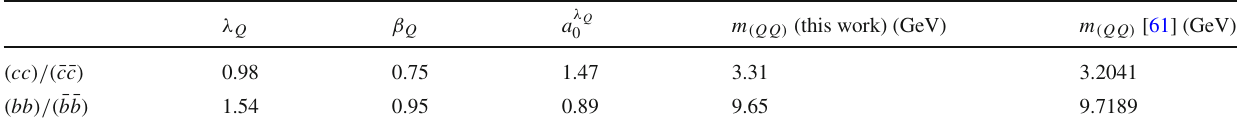
Table 4 Values of various auxiliary parameters for the charmonium and bottomonium diquark systems and the effective mass of the corresponding diquark λ Q λ β m ( QQ ) (this work) (GeV) m ( QQ ) [61] (GeV) Q Q a 0